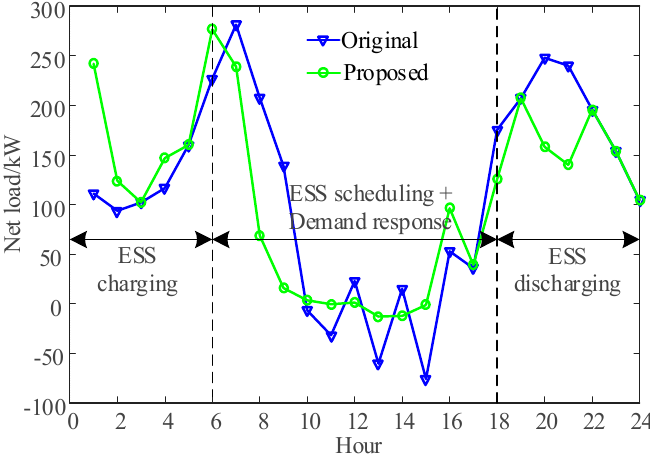
Figure 12. Comparison of net energy of MMGs.